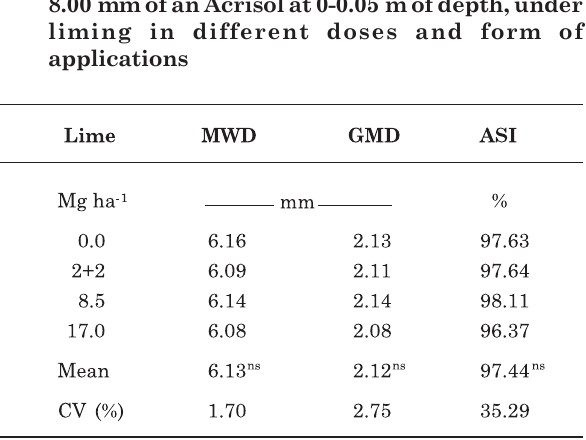
Table 2. Mean Weighted Diameter (MWD), Geometric Mean Diameter (GMD) and Aggregate Stability Index (ASI) calculated following the Kemper & Chepil (1965)